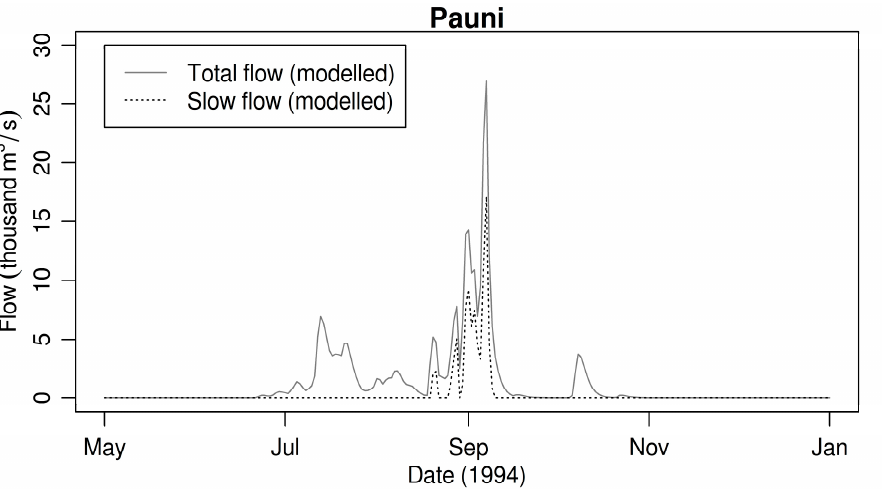
Figure 6. Modeled total flow and slow flow for Pauni, May–December 1994. Reduced variability in the modeled flows can also be seen in the FFC produced by fitting a Generalized Pareto distribution to the observed and modeled AMAX. Examples are reproduced for Ashti ( KGE ’ = 0.880) and Ramakona ( KGE ’ = 0.333) in Figure 7.